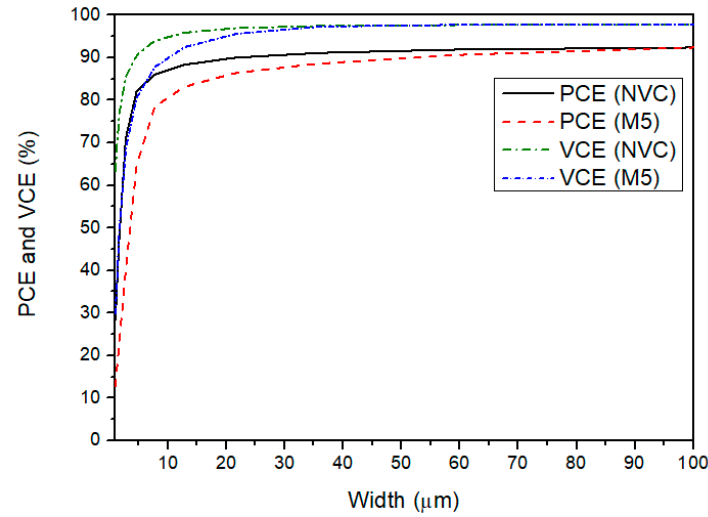
Figure 8. VCE and PCE features with the variation of the width of the NVC transistors and M5 (L = 0.13 µm).